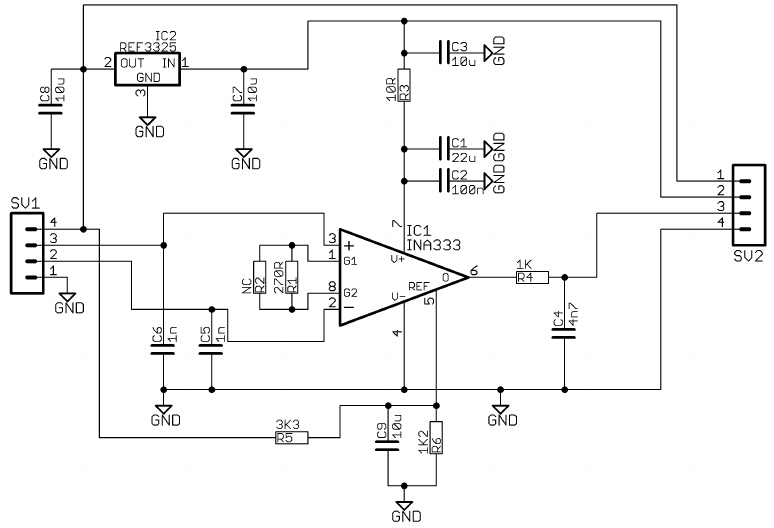
Figure A5. Electronic circuit of the air quality sensors (CCS811 of BioSense company) and tempera- ture-humidity (SHT31 of Sensirion company). Communication with the main processor occurs via I2C Bus.